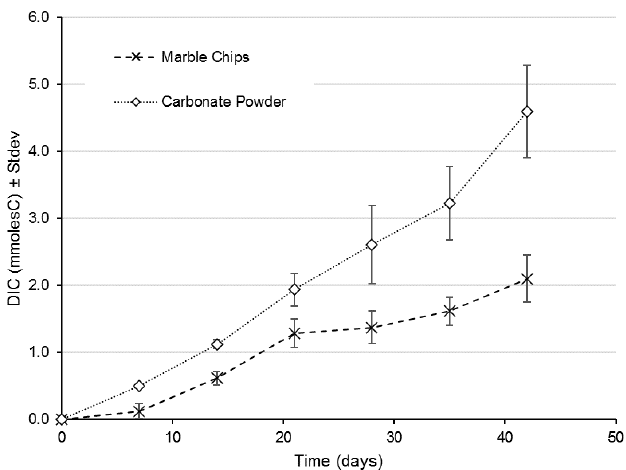
Figure 1. In abiotic reactions, there was evidence of the release of dissolved organic carbon into the reactor liquid phase from both marble chips and calcium carbonate